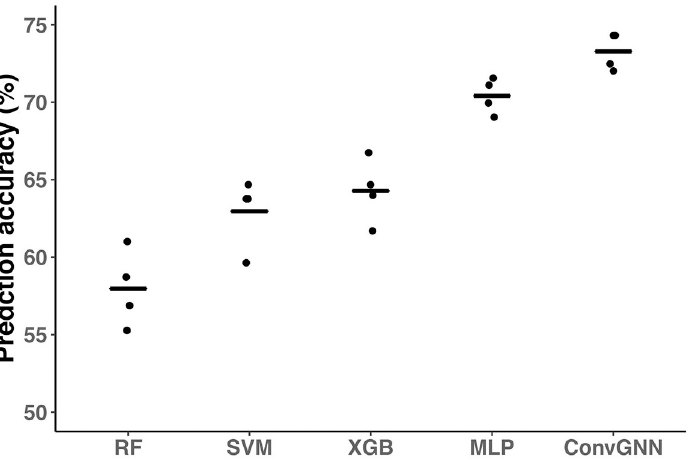
Fig 3. Multi-omics data integration through ConvGNN for COPD prediction. The ConvGNN models were trained in a 4-fold CV strategy with two omics data: proteomics and transcriptomics. The STRING PPI network was used for graph convolution. Besides ConvGNN, we also developed classification models with Random Forest (RF), Support Vector Machine (SVM), eXtreme Gradient Boosting (XGB), and Multi-Layer Perceptron (MLP) for comparison. The model performances are assessed using the prediction accuracies on the testing dataset. The lines represent the mean accuracies for CV-trained models.